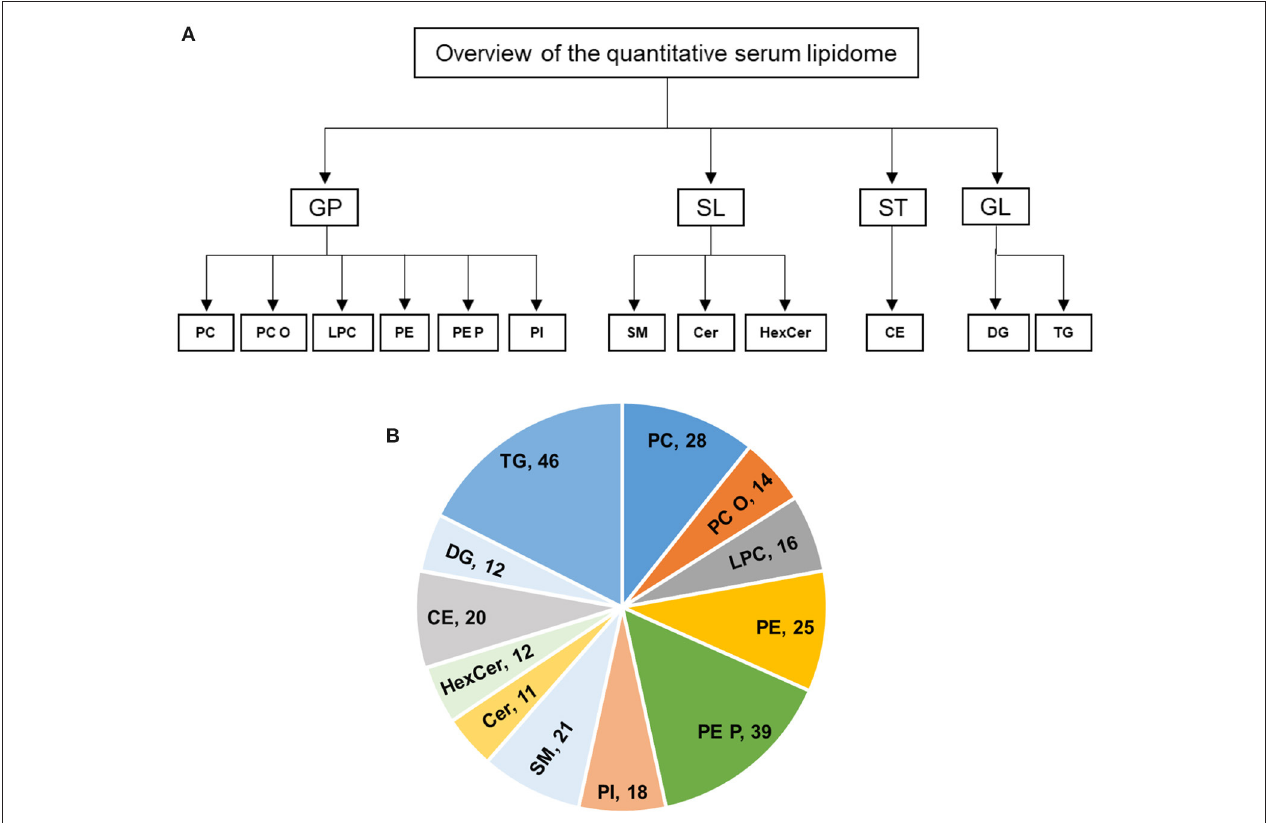
FIGURE 1 | (A,B) Overview of the quantitative lipidomic analyses of study groups by mass spectrometry. The numbers represent number of lipid species quantified for lipid class.